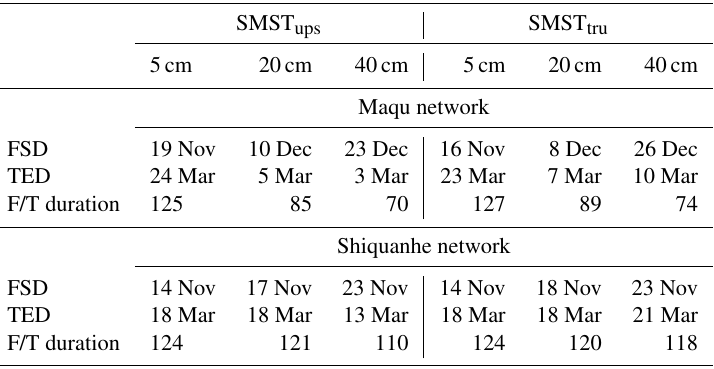
Figure 3. Comparisons between the time series of (a) SM ups and SM tru and (b) ST ups and ST tru at soil depths of 5, 20, and 40cm with 15min interval from 16 May 2010 to 16 May 2011 for the Maqu network. Table 4. Estimation of FSD, TED, and F/T duration at soil depths of 5, 20, and 40cm using the upscaled SMST profile dataset and ground truth in the selected single year for the Maqu and Shiquanhe